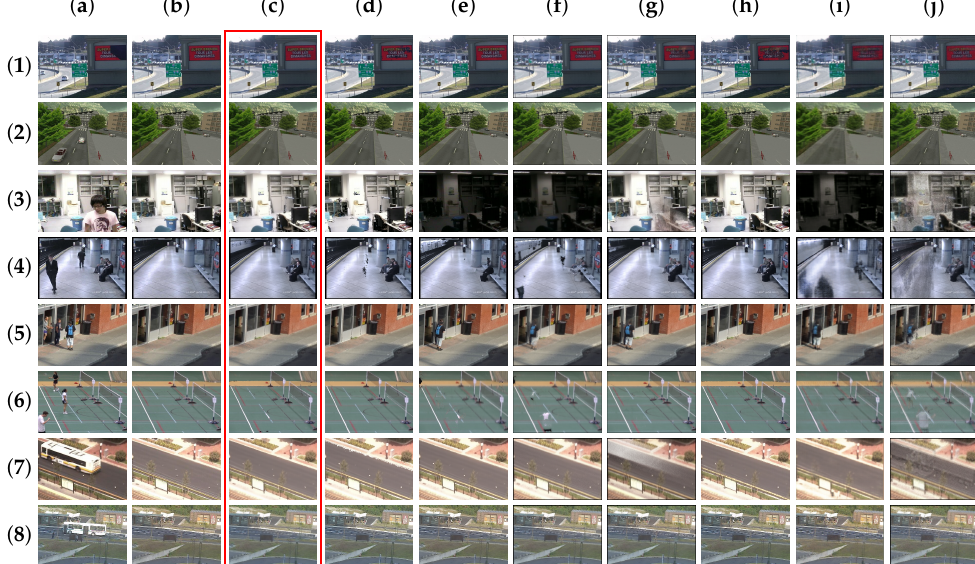
Figure 7. Visual quality comparison for background modelling on video sequences in SBM